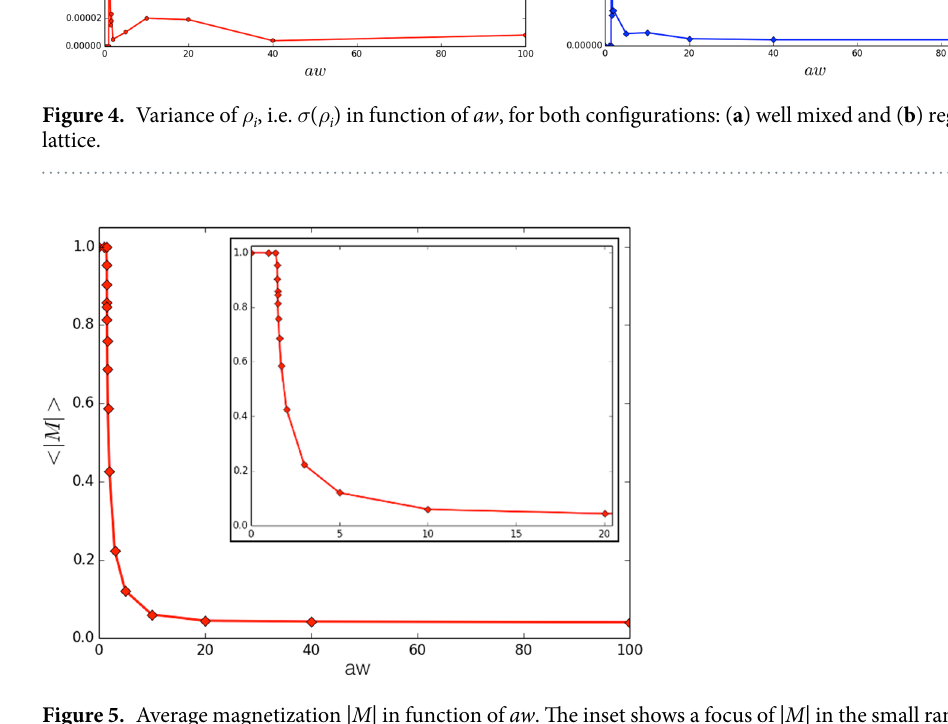
Figure 5. Average magnetization | M | in function of aw . The inset shows a focus of | M | in the small range close to the critical value, i.e. aw c